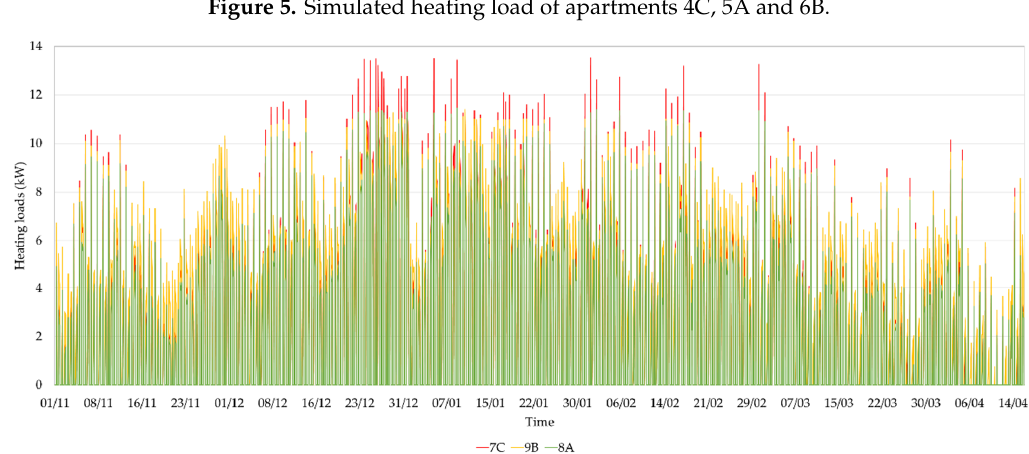
Figure 6. Simulated heating load of apartments 7C, 8A and 9B.